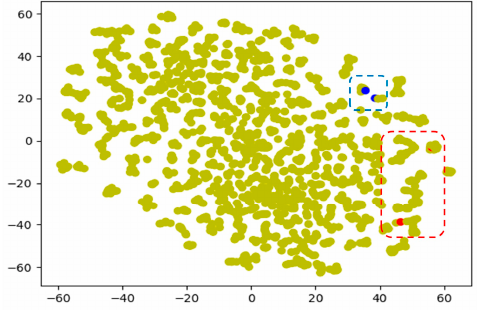
Figure 1. Word Distribution in